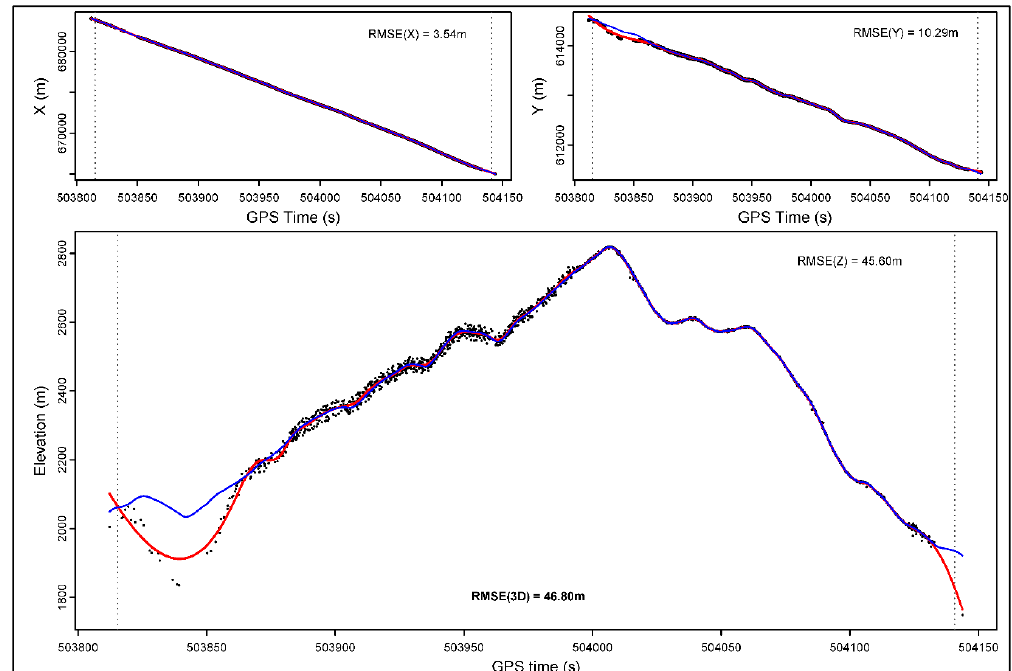
Figure A3. Example of spline fitting (red line) to a CPA set (points) and the recorded laser instrument trajectory, with each dimension present separately. The Z dimension is featured in larger scale to convey fit detail. Remote Sens. 2019 , 11 , x FOR PEER REVIEW